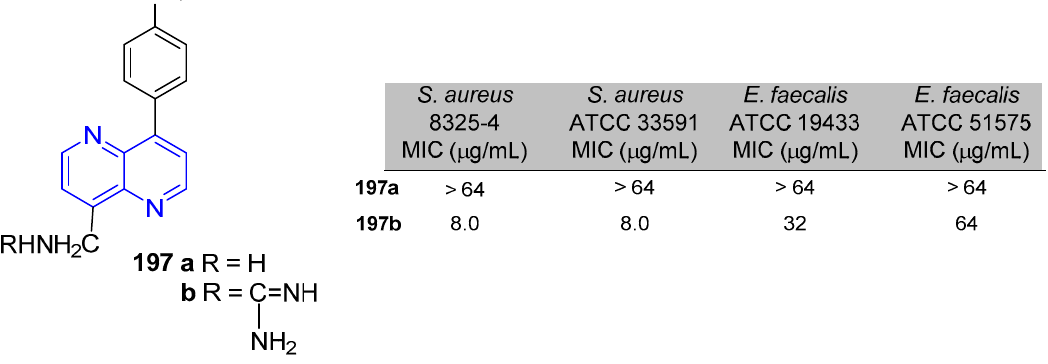
Figure 15. Antibacterial activity of some 1,5-naphthyridines against drug-sentsitive and drug- resistant